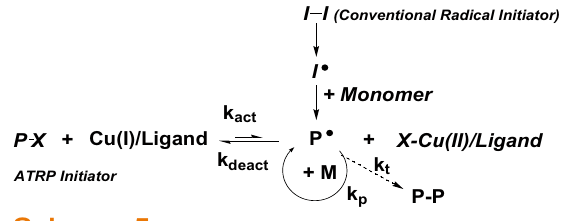
Scheme 5. Proposed mechanism for SR&NI process in ATRP. All ingredients present in the initial system are highlighted in italics.